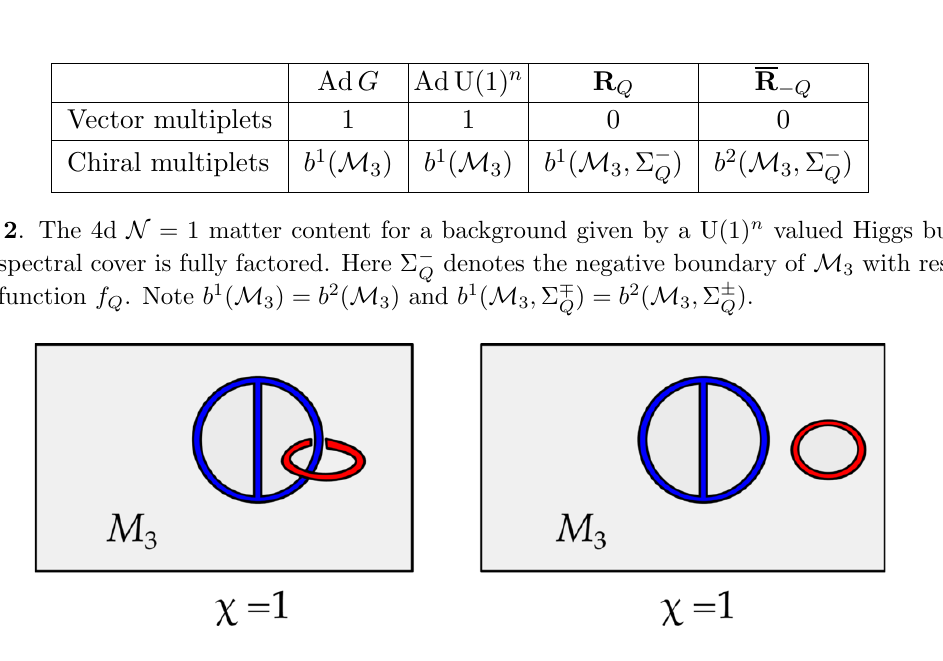
Figure 3 . Examples of charged graphs in M 3 . Positive, negative charges are coloured red, blue respectively. Both charge distribution give rise to the same chiral index but a di(cid:11)erent number of